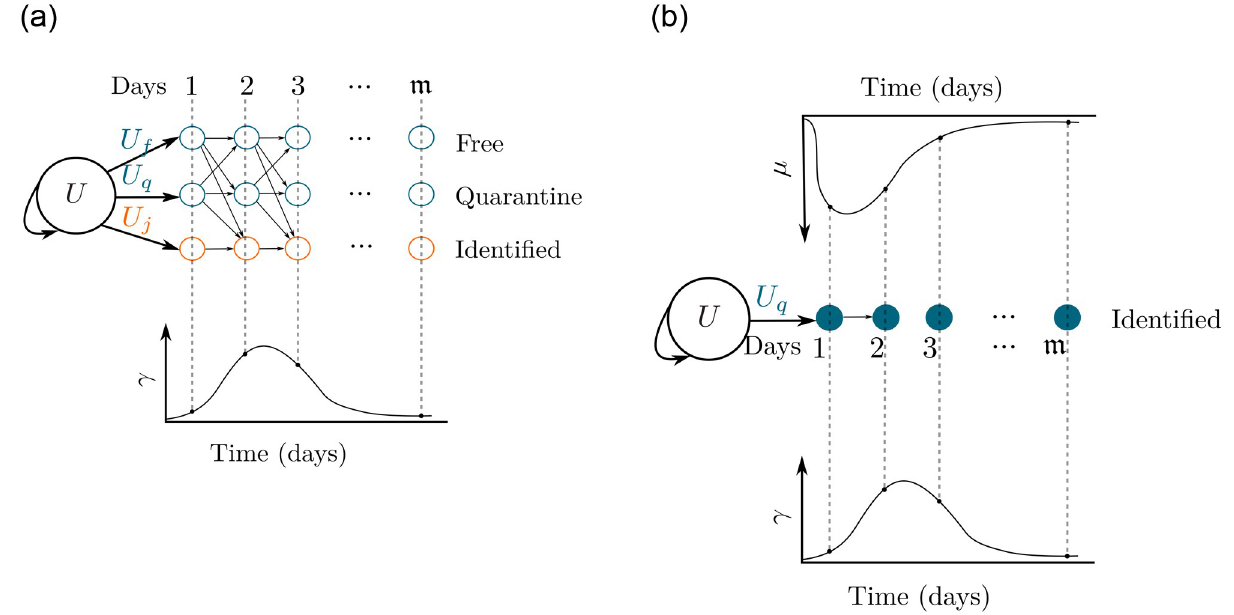
Fig 2. Example of two cases for diffusion systems. We propose discretized beta-shape functions to assign a probability for recovery or death in each level. Assigning an enumeration for the nodes and a priority for flows, it is possible to define correspondent random walk matrices.